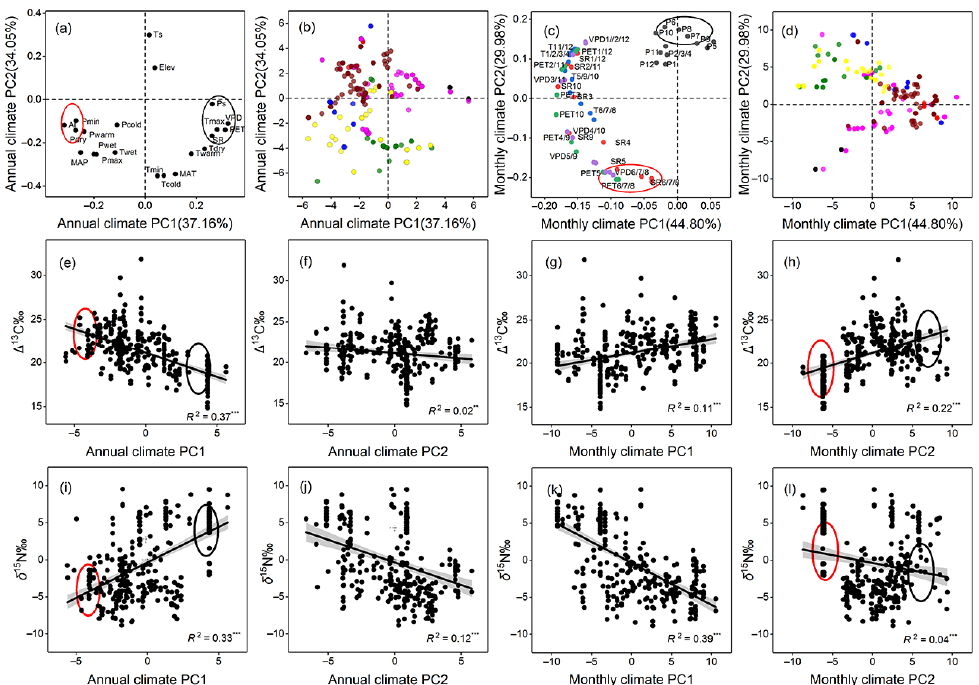
Figure 2. PCA of 474 woody plants based on 21 annual ( a , b ) and monthly ( c , d ) climate variables and the liner relationship between principal component (PC1 and PC2) and foliar isotope signals ( ∆ 13 C and δ 15 N) using SMA ( e – l ). ( a , c ) PC loadings and ( b , d ) observation scores with different colored symbols representing various biomes (DES, deserts = black; BOR, boreal forest = red; TMR, temperate rainforest = yellow; TMS, temperate seasonal forest = carmine; TRR, tropical rainforest = olive green; TRS, tropical seasonal forest = navy blue; WDS, woodland/shrubland = brown). Percentages explained by first two principal components were provided on the coordinate axis ( a – d ). Only significantly fitted results of the standardized major axis (SMA) regressions were reported in ( e – l ). In ( a – d ), the red (negative PC) and black (positive PC) circles correspond to ( e – l ). Significance of SMA regressions were indicated by *** p < 0.001 and ** p <